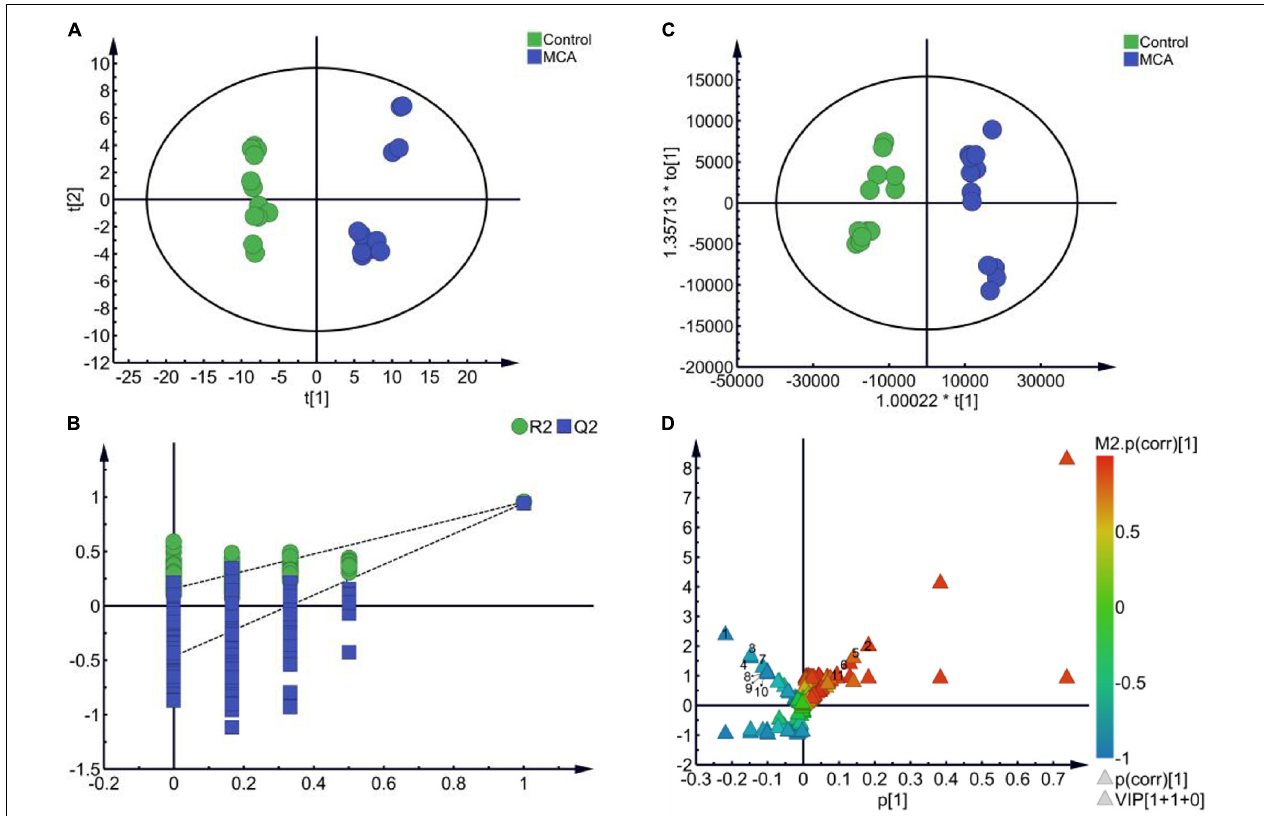
FIGURE 3 | Multivariate statistical analysis. (A) PCA score plots (R2X = 0.675, Q2 = 0.593). (B) OPLS-DA score plots (R2X = 0.909, R2Y = 0.954, Q2 = 0.944). (C) 200 permutation tests of PLS-DA. (D) (V + S) plot of OPLS-DA.